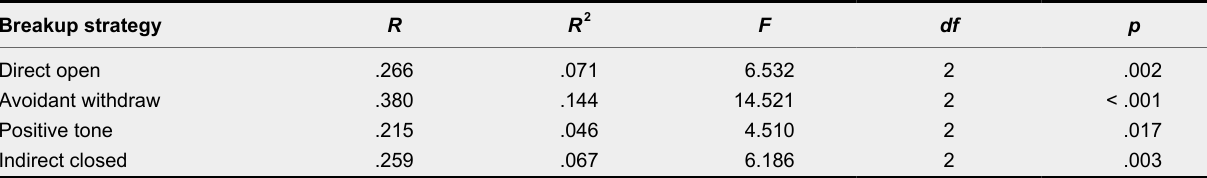
Predictors: Attachment Anxiety,